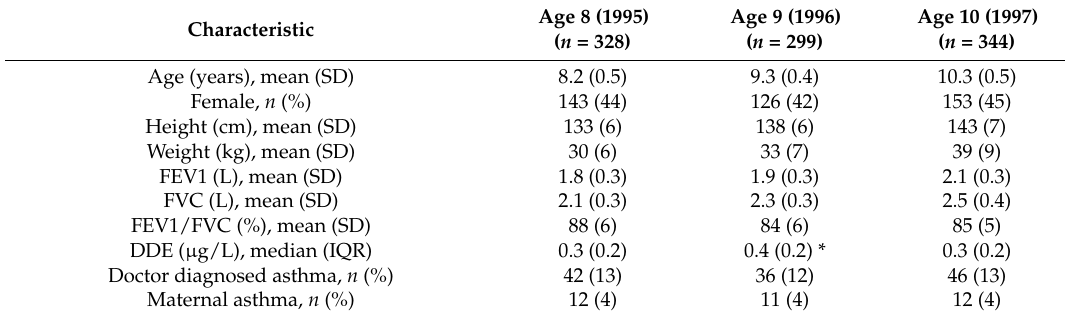
Table 1. Characteristics of the children with pulmonary function data (years 1995, 1996, and 1997) at ages 8, 9, and 10